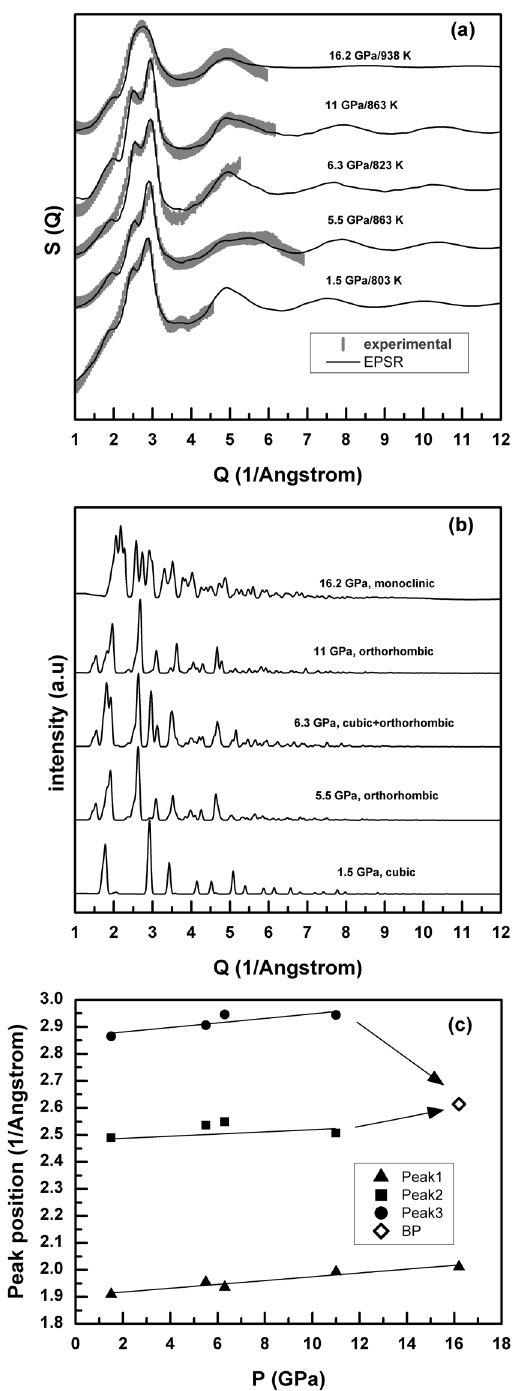
Figure 1. ( a ) Experimental (thick grey lines) and EPSR simulated (thin black lines) total structure factors, S ( Q ), for liquid AuGa 2 at different pressures. ( b ) Diffraction patterns for crystalline phases at corresponding pressures. ( c ) Pressure dependence of the liquid S ( Q ) peaks for 1.5 < Q < 3.5 Å − 1 , with Peaks 2 and 3 merging to form a broad peak ( BP ) at 16